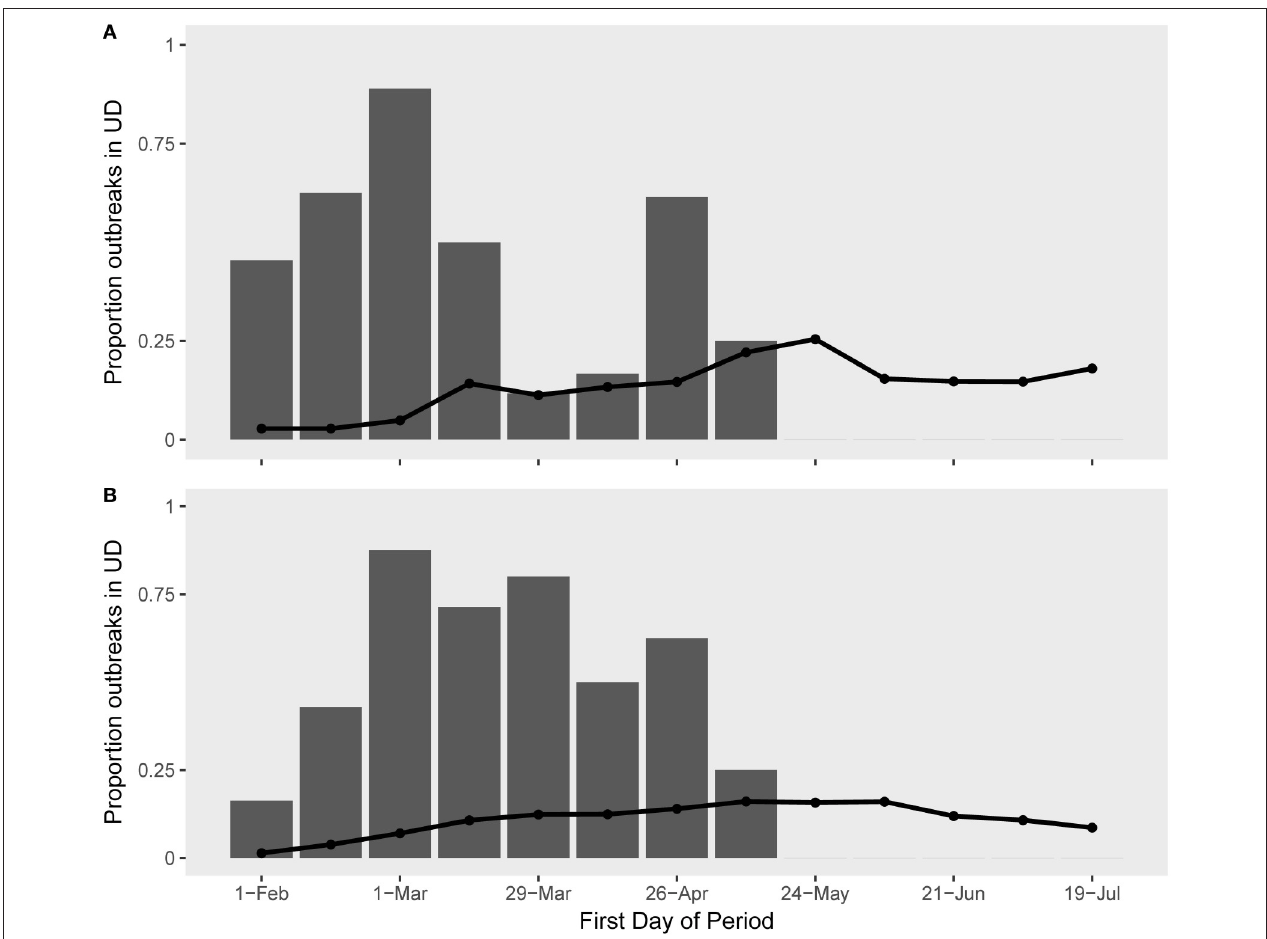
FIGURE 5 | The observed (bars) and expected (lines) proportions of H5N1 along the migratory route of (A) Eurasian wigeon and (B) northern pintail spatio-temporally associated with species presence.